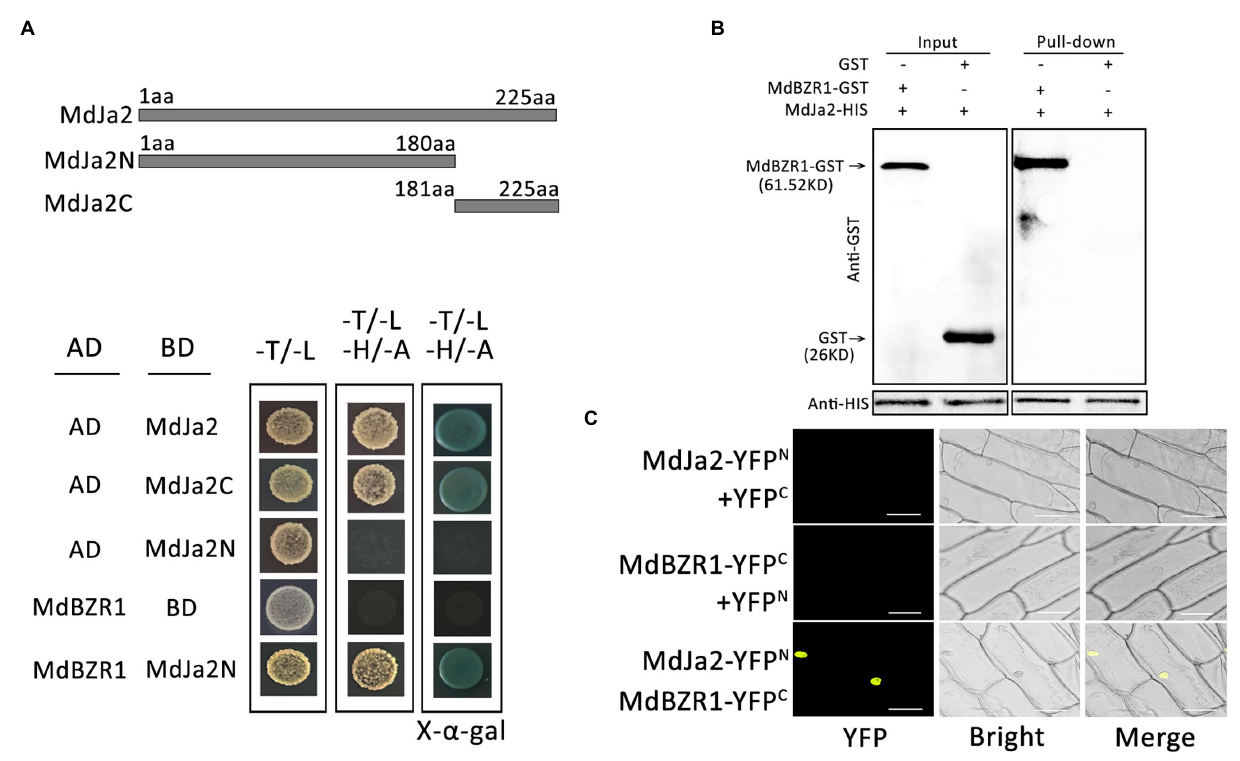
FIGURE 5 | Interaction between MdJa2 and MdBZR1. (A) Schematic diagram of the MdJa2 protein structure. Yeast two-hybrid (Y2H) assays were used to analyze the interaction between MdJa2 and MdBZR1. The empty AD and BD vectors were used as controls. (B) Pull-down assays were performed by co-purifying the recombinant MdJa2-HIS fusion protein with MdBZR1-GST (column 1) and GST alone (column 2). A western blotting analysis involving an anti-GST antibody indicated that MdBZR1-GST was pulled down by MdJa2-HIS. (C) Confirmation of the interaction between MdJa2 and MdBZR1 in vivo according to a bimolecular fluorescence complementation assay. Scale bar = 50 μ